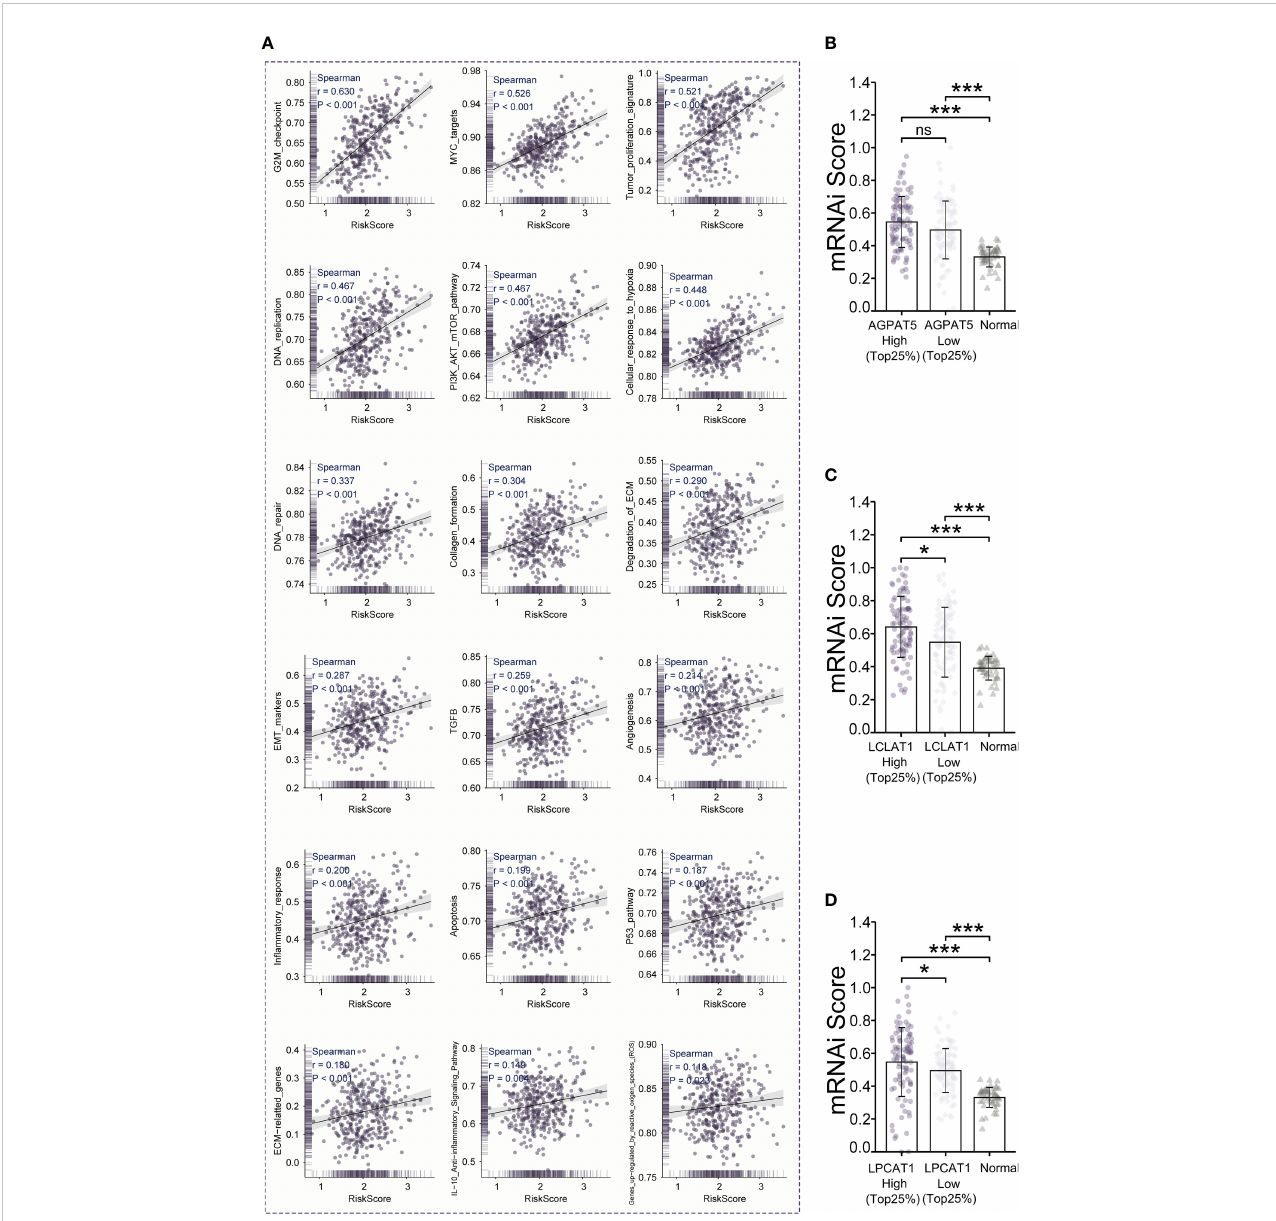
FIGURE 4 Tumor-associated signaling pathway analysis and stemness index (mRNAsi) analysis. (A) Analysis of the correlation between risk scores and 18 tumor signaling pathways. (B – D) Comparison of mRNAsi in the high- and low-gene-expression ( AGPAT5 , LCLAT1 , and LPCAT1 , respectively) groups. Signi fi cance signs: ns, p ≥ 0.05; *p< 0.05; **p< 0.01; ***p<